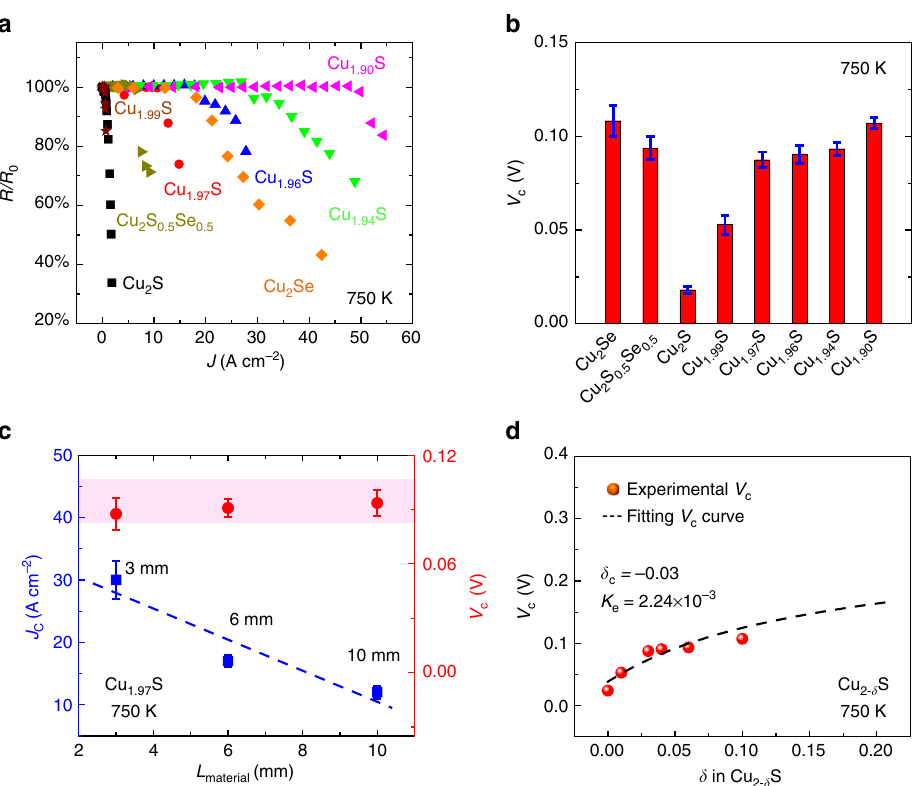
Fig. 2 Critical electric potential difference ( V c ) in the isothermal case. a Current density dependence of relative electrical resistance variation ( R / R 0 ) for several Cu-based mixed ionic/electronic conductors with L = 10 mm. b Experimentally determined V c ( L = 10 mm). c Material length L dependences of V c and the critical current density J c for Cu 1.97 S. The dashed line is a guide to the eyes. d V c as a function of Cu off-stoichiometry δ in the Cu 2- δ S ( δ = 0, 0.01, 0.03, 0.04, 0.06, and 0.1) samples with L = 10 mm. The dashed line represents the V c curve based on Eq. 7. All measurements were carried out at